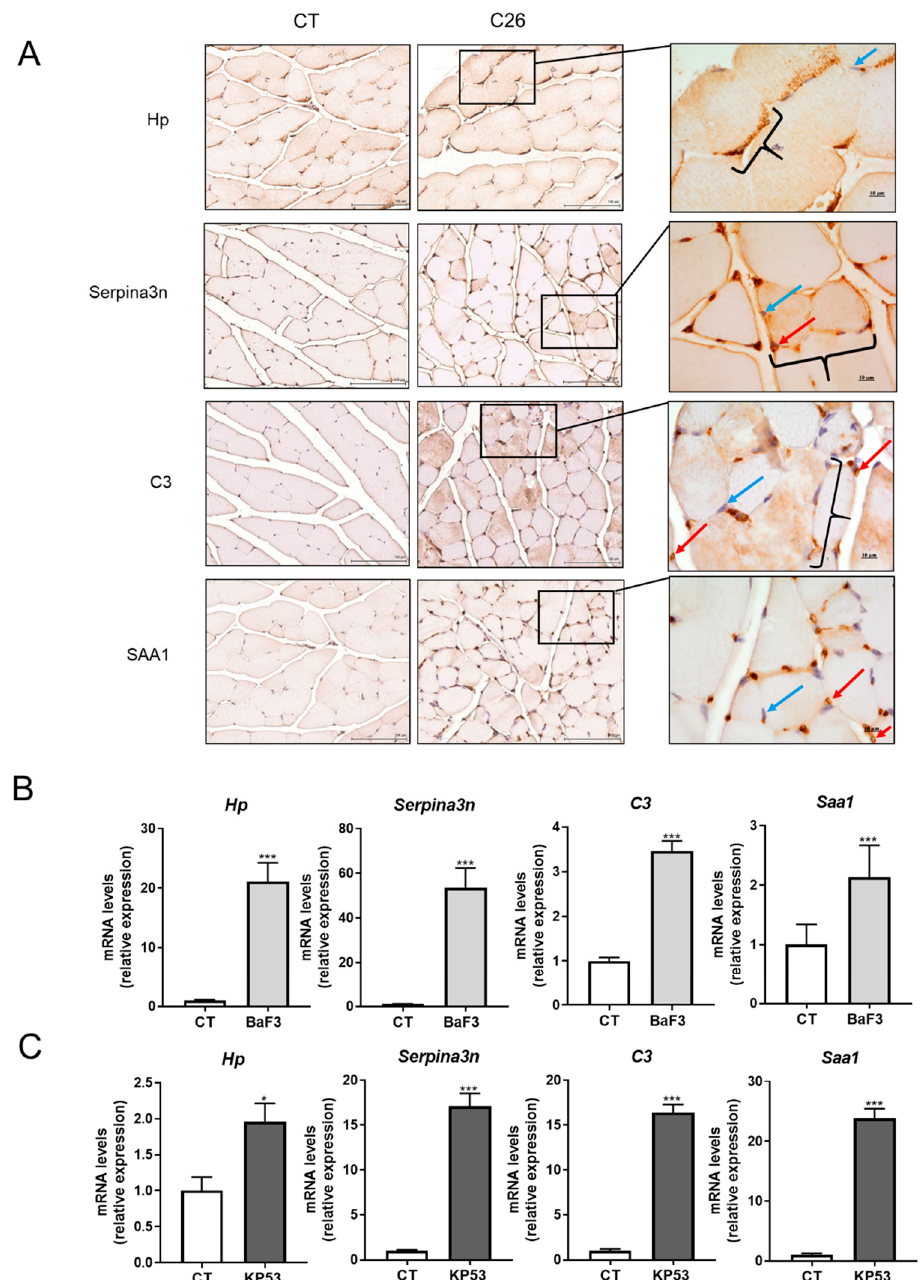
Figure 4. Marked production of acute phase reactants (APR) is observed in the skeletal muscle of mouse models of cancer-induced cachexia. ( A ) Immunohistochemical staining for Hp, Serpina3n, C3, and SAA1 in FFPE sections of GC muscle of C26 and CT male mice. Scale bar = 100 µm. Scale bar = 10 µm in zoom insets. Blue arrow shows nuclei located at the periphery of the cell. Red arrow shows capillaries. Bracket shows muscle fiber containing the protein of interest. ( B ) Hp , Serpina3n , C3 , and Saa1 mRNA relative levels in the GC muscle of female mice injected with BaF3 cells (BaF3) or vehicle (CT) and ( C ) Hp , Serpina3n , C3 , and Saa1 mRNA relative levels in the GC muscle of KP53 or CT male mice. Data are reported as means ± SEM ( n = 5–10/group). * p < 0.05 and *** p < 0.001 vs. CT.